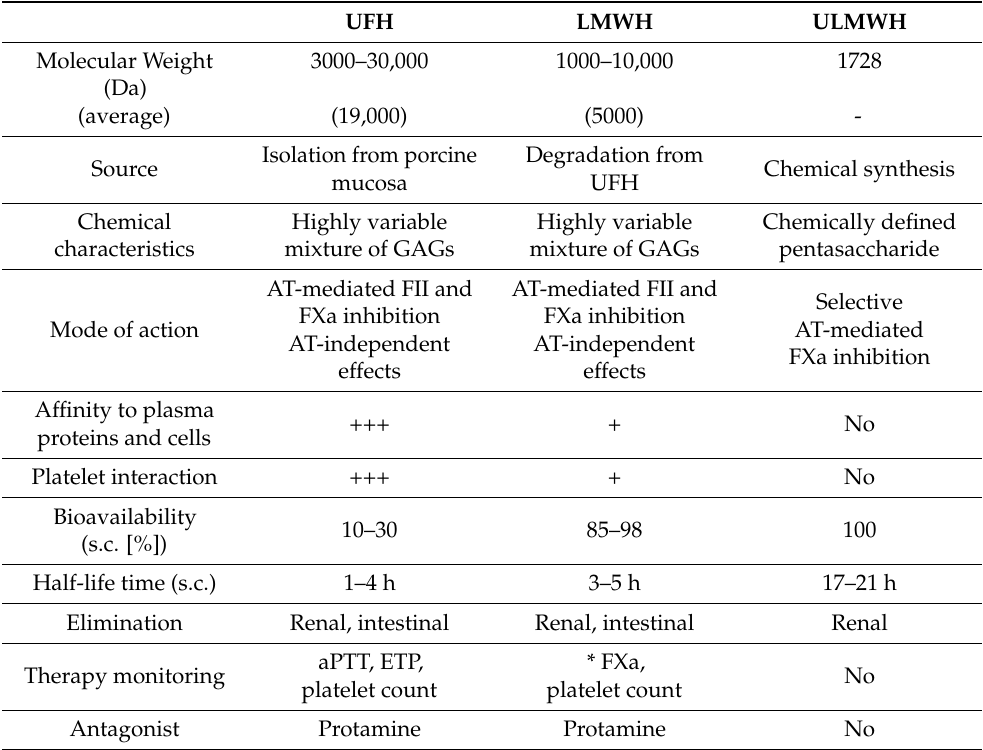
Table 1. Characteristics of unfractionated heparin (UFH), low molecular weight heparins (LMWH) and ultra (U)LMWH (fondaparinux, as representative of synthetic pentasaccharides); modified from [29,31–33]. Abbreviations: AT: antithrombin; GAGs: glycosaminoglycans; h: hours;